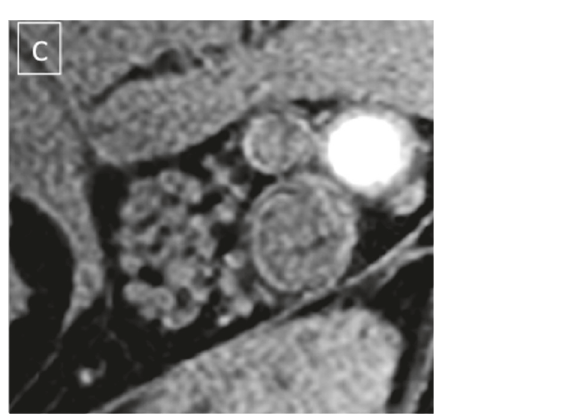
Figure 1: (A) Ankle, axial plane. Sequence: 3D SPGR IDEAL-water image. (B) Neurovascular bundle with the tibial nerve. Sequence: TSE T1 weighted. The nerve fascicles appear dark over a brighter background, corresponding to the epineurial fat. (C) Sequence: 3D SPGR-water image. The fascicles appear bright over a dark background corresponding to the epineurium. The perineurium can be seen surrounding some of the fascicles (see Figure 2).